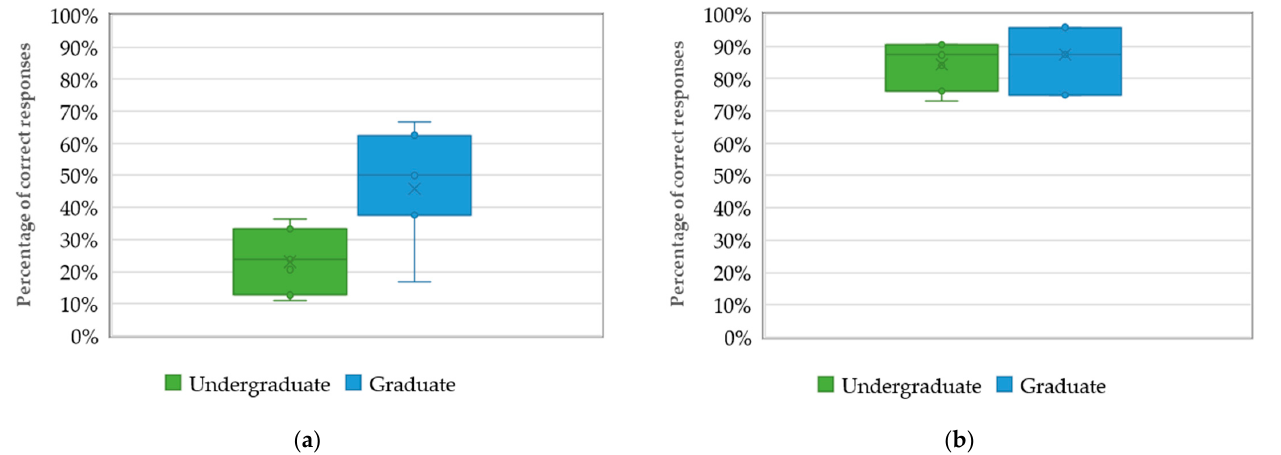
Figure 11. Comparison of correct pre-game and post-game responses of undergraduate and graduate students. ( a ) Pre-game correct responses of undergraduate and graduate stu-dents; ( b ) Post-game correct responses of undergraduate and graduate students.